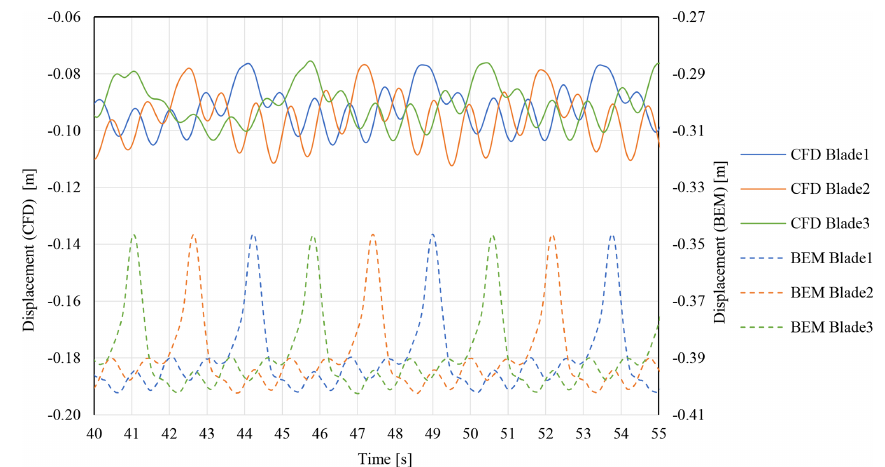
Figure 15. Blades edgewise displacements of the CFD and BEM